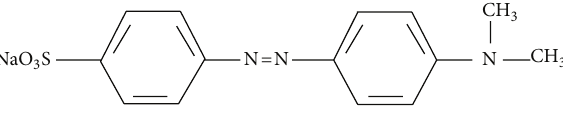
Figure 1: Chemical structures of methyl